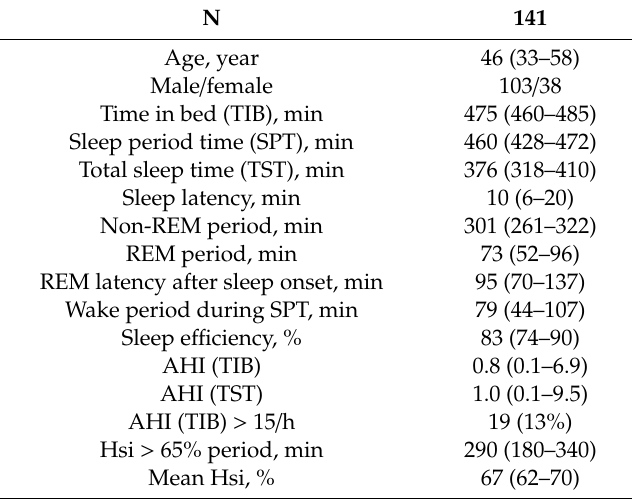
Table 1. Characteristics of subjects.